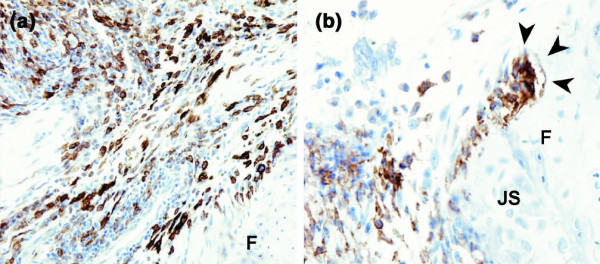
Expression of macrophage marker F4/80 in knee joints of day 7 IFN-γ-stimulated ICA. Note that 70 to 80% of the infiltrated cells within the synovium consist of macrophages (a). Arrowheads in (b) indicate F4/80-positive macrophages attached to the cartilage surface and found in the lacunae of erosion pits. Original magnification × 400. F, femur; JS, joint space.